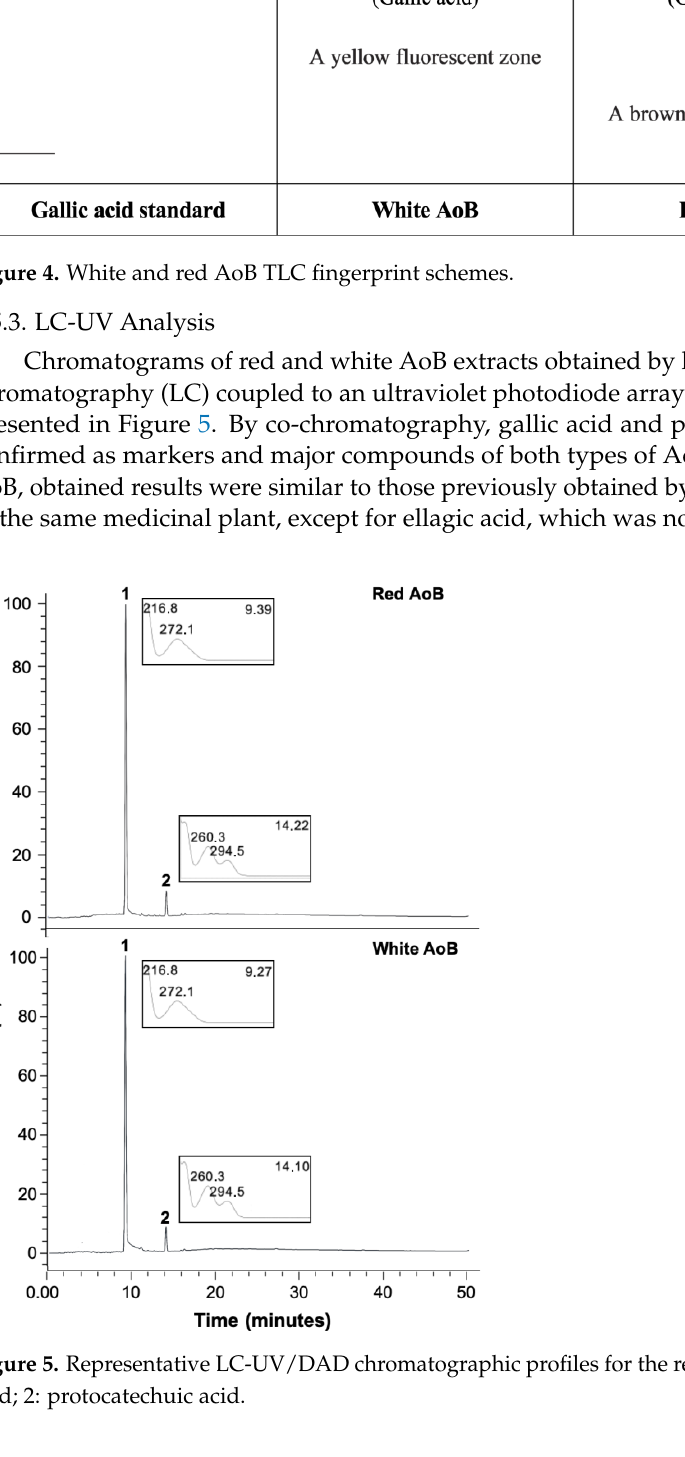
Table 4. Spectrophotometry quantification of secondary metabolites on A. occidentale stem barks. Content Assay